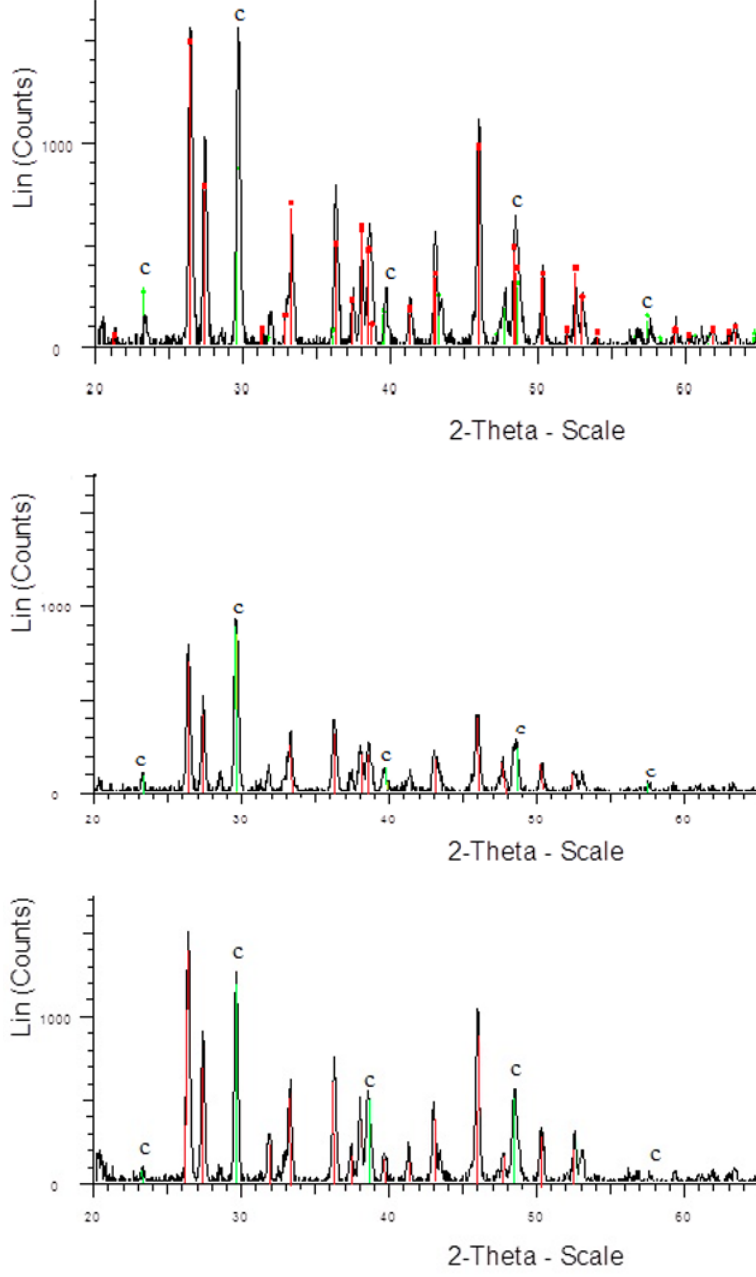
Figure 5. Powder diffraction patterns of CaCO : C denotes calcite peak (marked green), aragonite peaks are marked red; The highest pattern: 3 untreated water, in the middle: water treated with EGD and the lowest pattern: magnetically treated untreated water precipitate. Therefore we can conclude peak heights for calcite at 30 on 2-Theta-Scale was that in untreated water (the upper sample) higher 950 counts for EGD treated sample and 1250 counts for calcite/aragonite fraction is obtained compared with the magnetically treated water, respectivelly. It is obvious that treated samples. Fig. 6 represents the powder diffraction calcite in not predominant fraction. The diffractograms of patterns of CaCO the precipitate from water treated by EGD and a magnet from hotel pipeline samples: upper 3 still show some calcite fraction peaks, but the number is made in sample of untreated water and the lower of of these peaks is lower compared with the number in EGD treated water. Peaks denoted by «C»represent